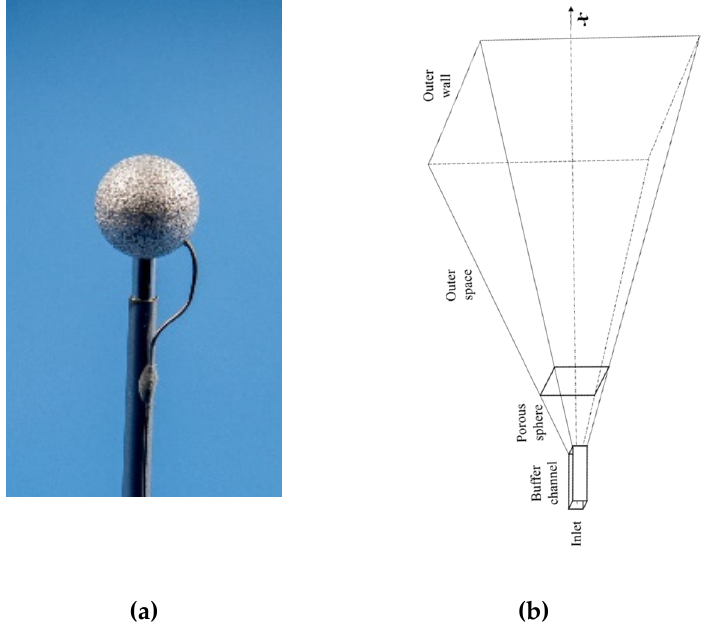
Figure 1. Photograph of the porous sphere mounted on a gas supply tube ( a ) and the schematic of the computational domain ( b ).